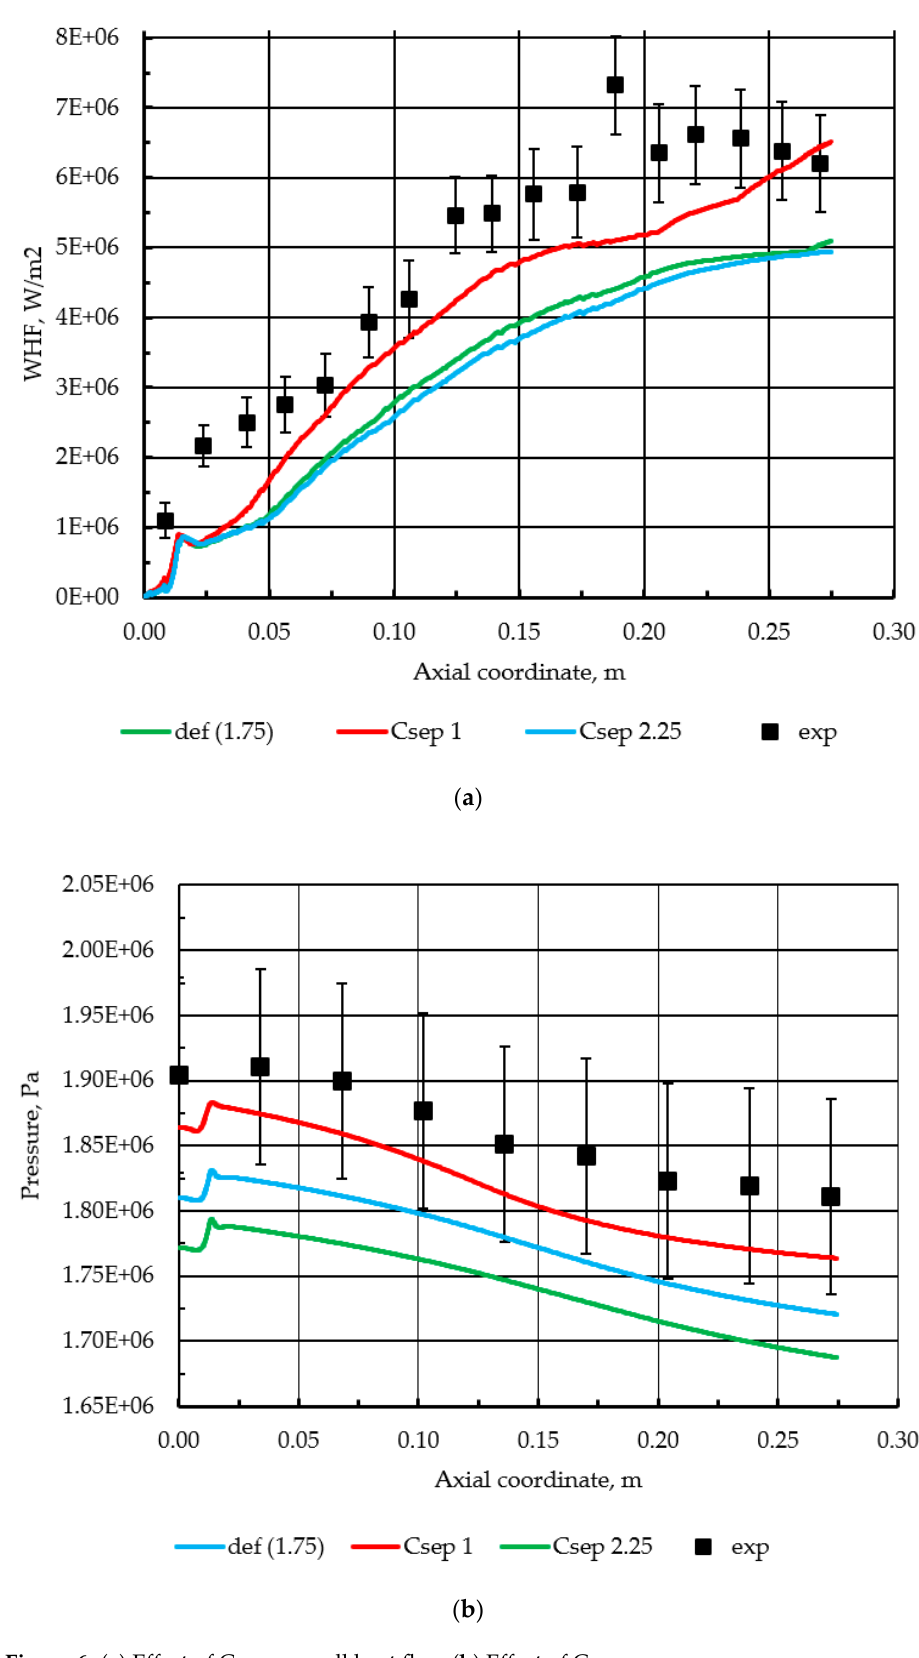
Figure 6. ( a ) Effect of Csep on wall heat flux; ( b ) Effect of Csep on pressure.